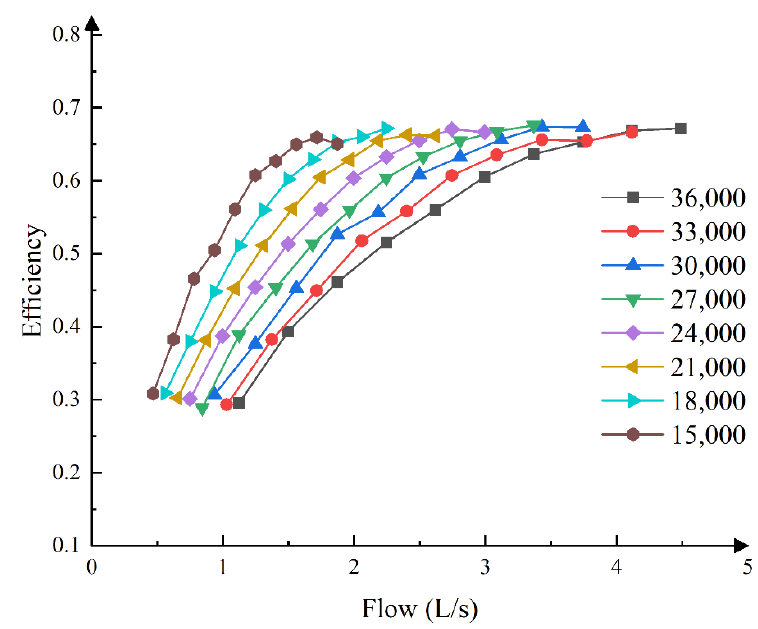
Figure 7. Pump efficiency vs. flow curve under different speeds.